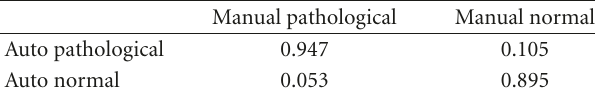
Table 3: Confusion matrix for the one correlation case (Test set).